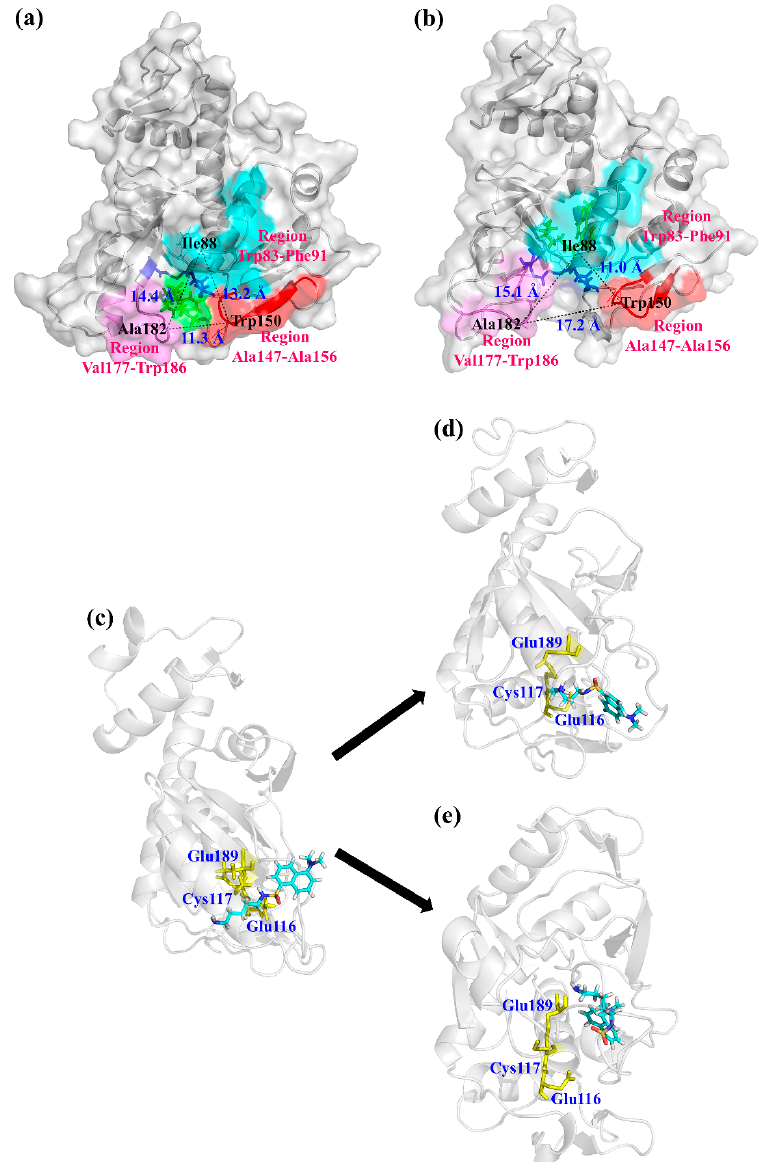
Figure 5. The structural illustration of BCETG-MDC at ( a ) 323 K and ( b ) 353 K. ( a ) The front view for the conformation of BCETG-MDC at 323 K at the end of molecular dynamics simulation. ( b ) The front view for the conformation of BCETG-MDC at 353 K at the end of molecular dynamics simula- tion. The Trp83-Phe91, Ala147-Ala156, and Val177-Trp186 regions are labeled in cyan, red, and ma- genta, respectively. The structure of BCETG is exhibited in gray. ( c ) The side view for the confor- mation of BCETG-MDC at the beginning of molecular dynamics simulation. ( d ) The side view for the conformation of BCETG-MDC at 323 K at the end of molecular dynamics simulation. ( e ) The side view for the conformation of BCETG-MDC at 353 K at the end of molecular dynamics simula- tion. The active center is colored in yellow. The structure of BCETG and MDC are shown in gray and cyan, respectively.